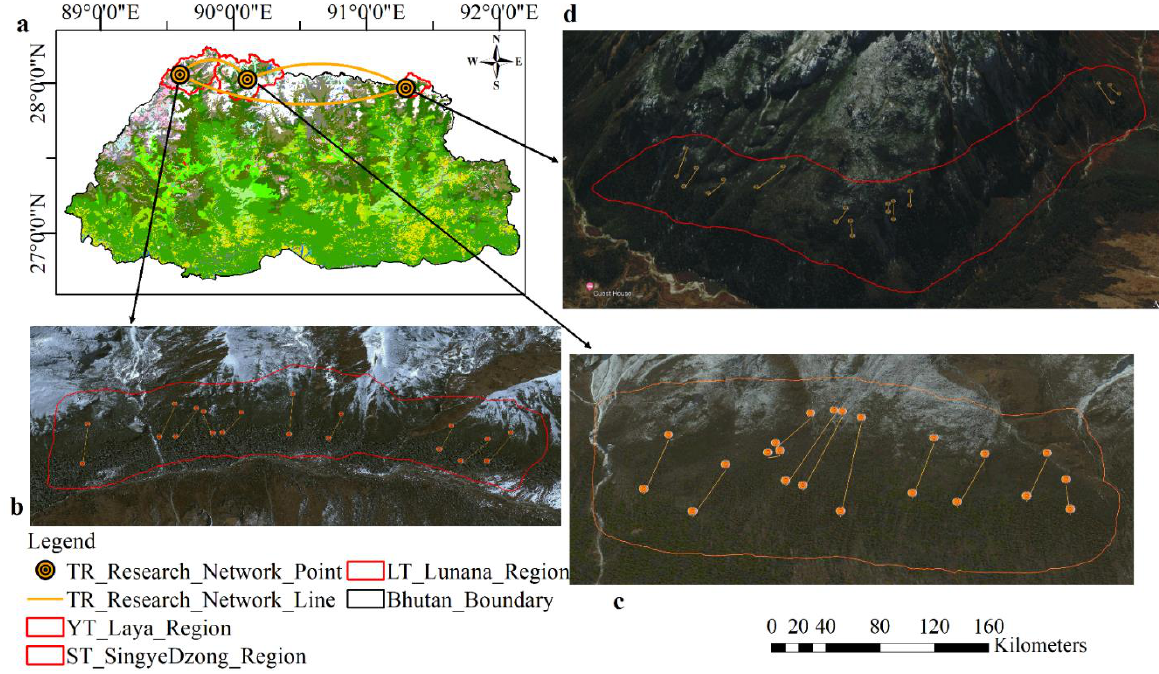
Figure 2. Treeline ecotone network regions and transect band sampling layout in Northern Bhutan. Three specific treeline ecotone sites (golden concentric circles) and three treeline ecotone regions (Lunana, Laya and Singye Dzong — pink shaded polygons) are connected by golden thick curved lines. Map of three regions (scale is drawn) of sampling treeline ecotones, where transect bands (golden thick line) and stations (brown concentric circles) were laid, shown in ( b ) Laya, ( c ) Lunana and ( d ) Singye regions. ( a ) Land use types are shaded by various colours; fir forest cover is shaded by dark green colour and glaciers/snows by white colour (upper right panel). These figures were generated using ArcGIS10.8, Google Earth Pro 2022, and GPS data.